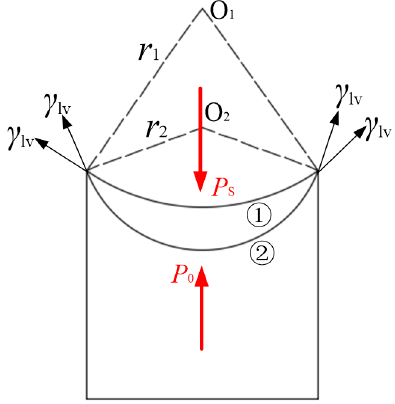
Figure 4. Diagram of drop curvature change in texture.